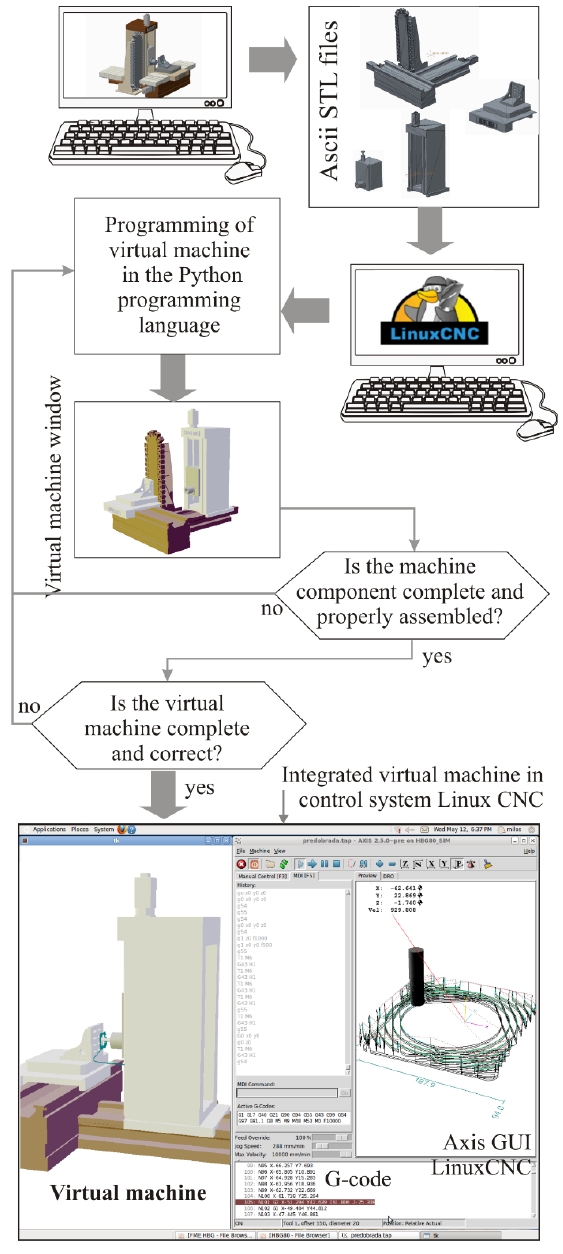
Figure 12. Basic concept of configuring and integrated a virtual machine in the control system LinuxCNC